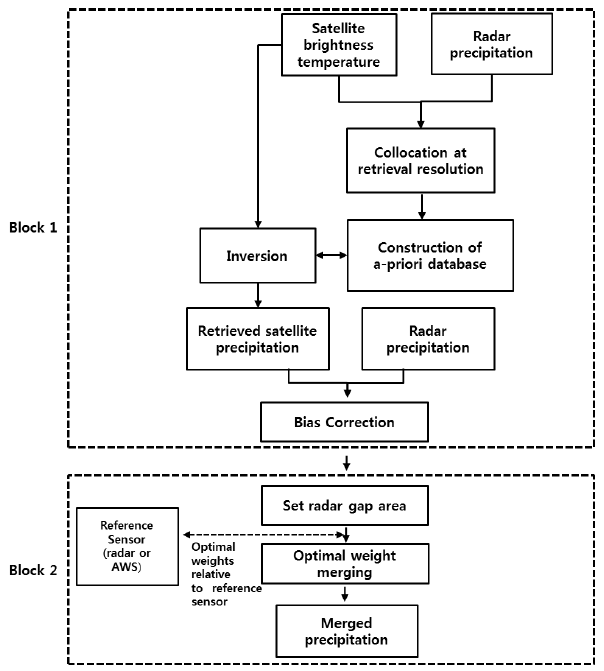
Figure 2. The location of the Jindo radar (red triangle) and its ob- servational coverage (black circle), which indicates the study